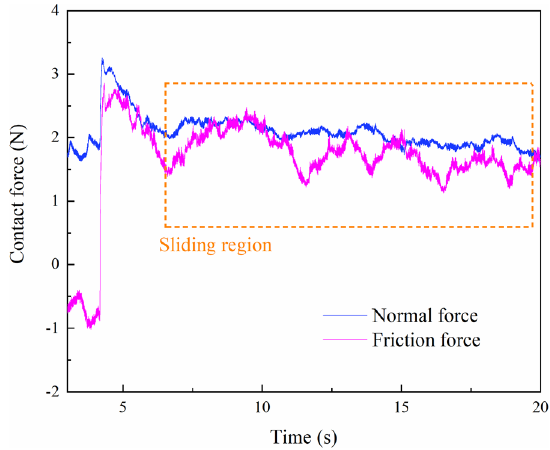
Figure 13 Normal force and friction force for rotating